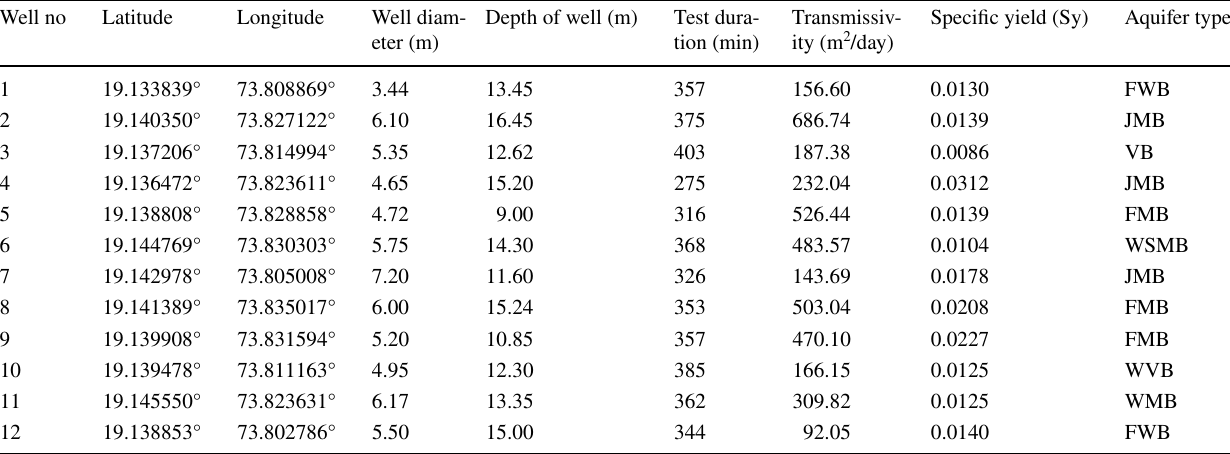
Table 2 Determination of aquifer parameters using pumping test data